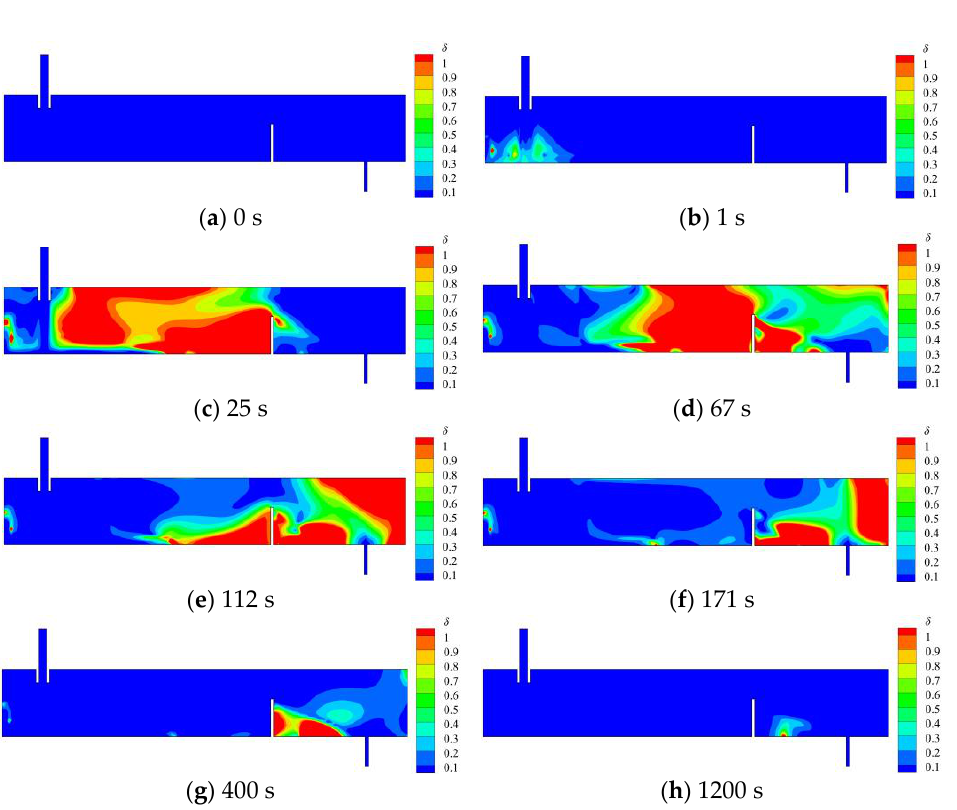
Figure 12. The distribution of velocity difference number δ in the tundish at different moments: (a) 0 s; (b) 1 s; (c) 25 s; (d) 67 s; (e) 112 s; (f) 171 s; (g) 400 s; (h) 1200 s.